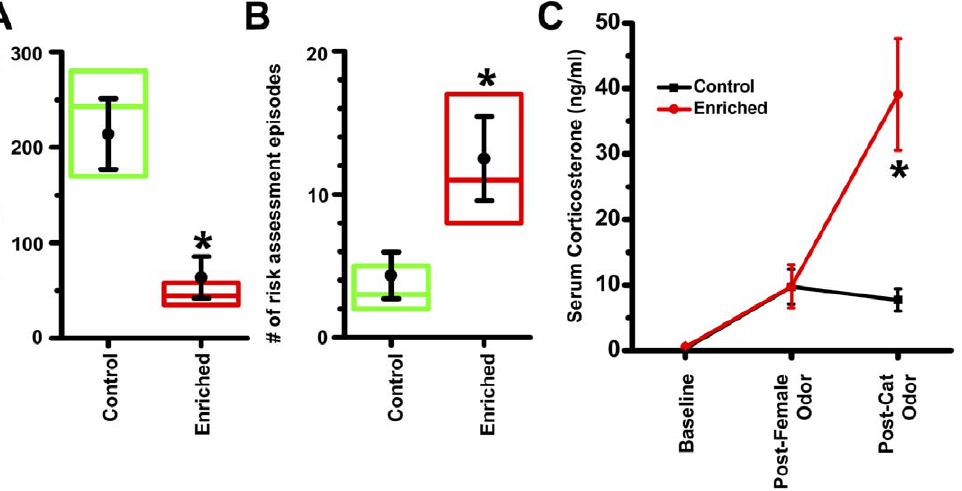
Figure 3. Enriched males are more defensive to predator. When presented with a towel containing bobcat urine, enriched animals spent less time in vicinity of odor (A) and engaged in greater risk assessment (B). n=6 males for each group. Enriched animals secreted greater amount of stress hormone, corticosterone, when exposed to cat odor (C). n=6 males for each group. *, p , 0.05; exact Mann-Whitney test between control and enriched.